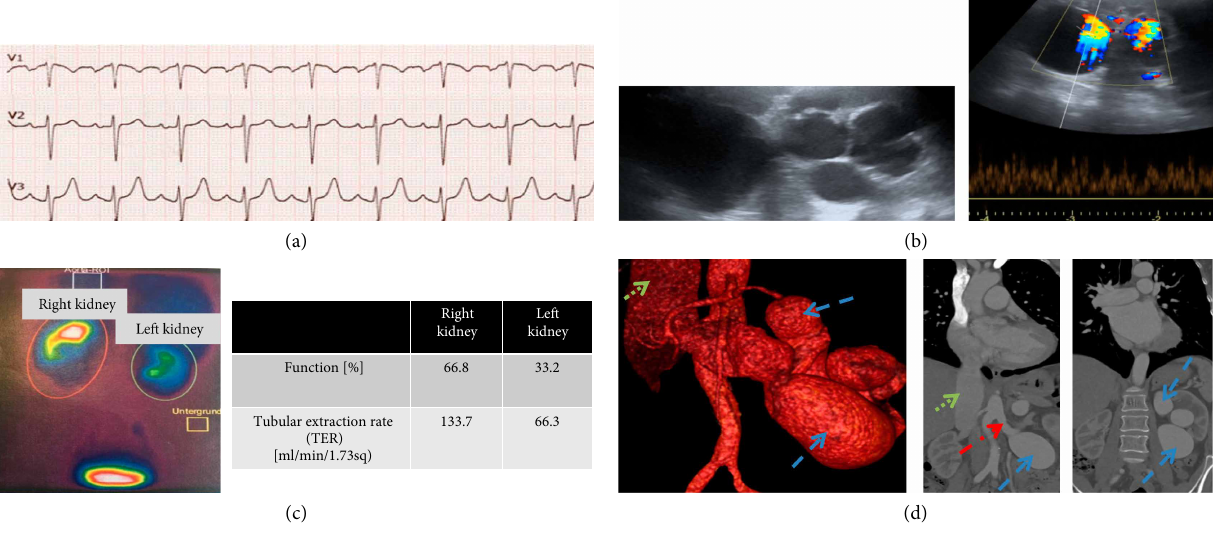
Figure 1: Clinical finding and imaging prior to renal arterio-venous fistula (RAVF) occlusion. (a) Electrocardiogram (ECG) with sinus tachycardia in precordial right heart leads V1–3. No pathological ECG intervals. (b) multiple renal vein aneurysm (RVA) with broadening of spectral waveforms suggesting arterial aneurysm perfusion. (c) Renal scintigraphy (MAG-3) found a split renal function of left: 33% vs. right: 67% since a proximal high-flow RAVF caused reduced kidney perfusion. (d) 3D and coronal reconstruction. RVA (blue arrows, dashed) which are likely to be a long-term sequalae from a proximal high-flow RAVF. Recognize the straight proximal segment of the left renal artery (LRA) (red arrow, dashed, and dotted) for Amplatzer Vascular Plug (AVP) placement. Recognize the diameter enlargement of the Inferior Vena Cava (IVC) (green arrow, dotted) caused by increased volume